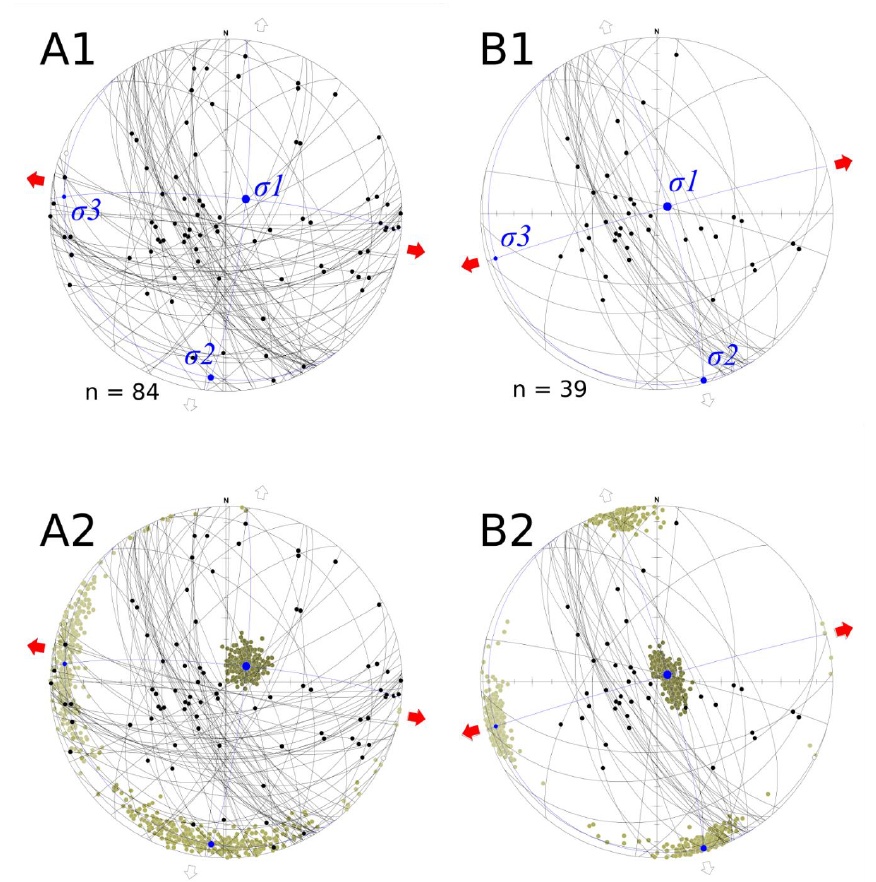
Figure 11. Stress inversion results for both inversion A and inversion B, with all subfigures denoted with ‘A’ related to inversion A and all subfigures denoted with ‘B’ related to inversion B. Subfigures ( A1 , B1 ) display the calculated three principal stress orientations ( σ 1 > σ 2 > σ 3), along with measured fault planes, associated slicken lines, and the dominant stretching direction (red arrows). Subfigures ( A2 , B2 ) show the error calculations associated with the stress inversions. All plots in this figure were produced in MyFault version